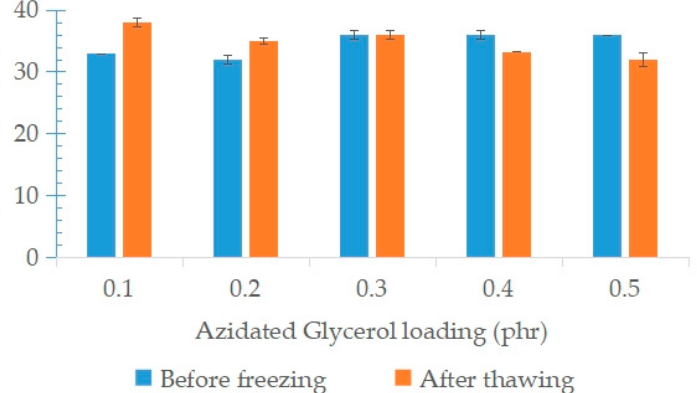
Figure 14. Viscosity of NRL containing variable loadings of AG before freezing and the after freeze– thaw processes.